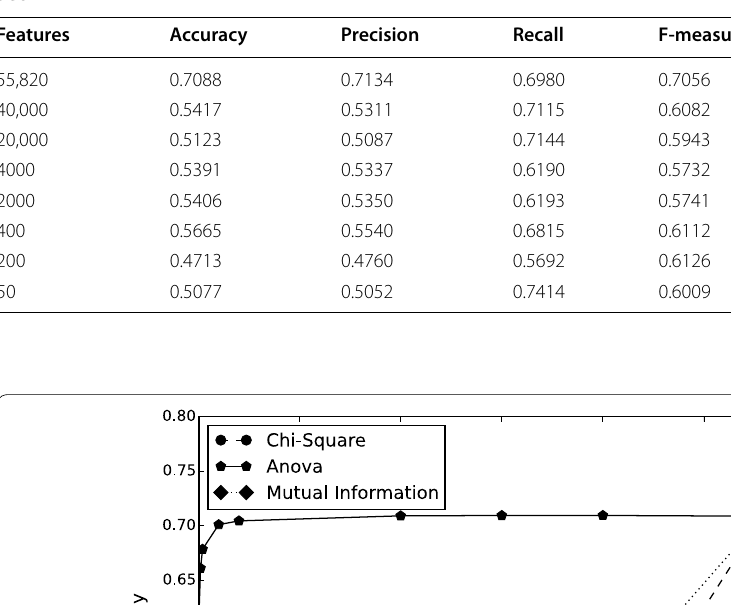
Table 4 Performance of the mutual information feature selection on the StockTwits data- set